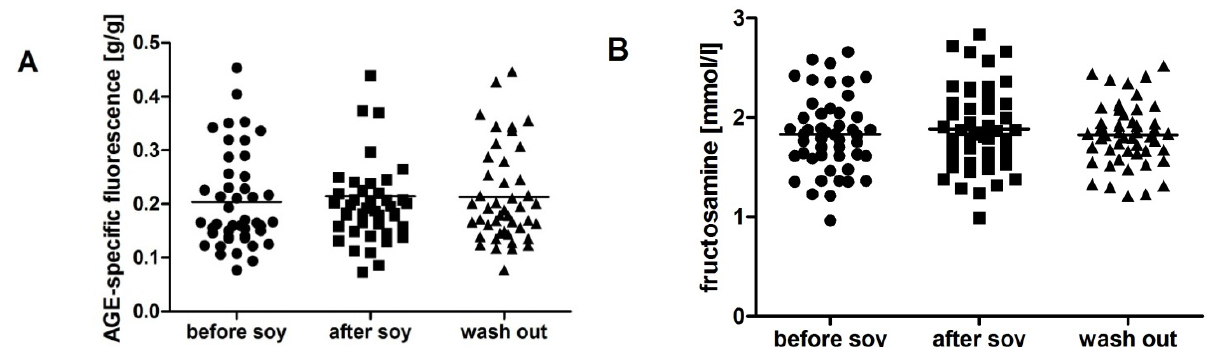
Figure 3. Carbonyl stress parameters in women. Soy intake did not affect advanced glycation end products (AGE-specific fluorescence; A ). No changes were found in plasma fructosamine levels ( B